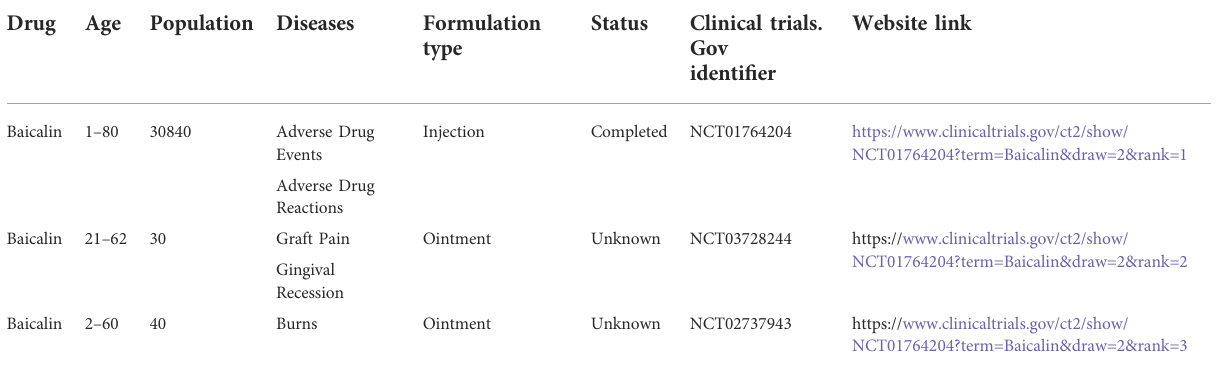
TABLE 1 Clinical trials of Baicalin in various diseases (www.clinicaltrials.gov).